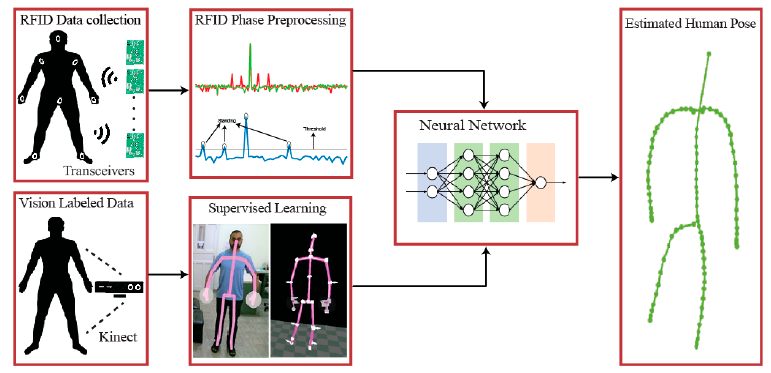
Figure 1. Proposed human pose analysis framework.